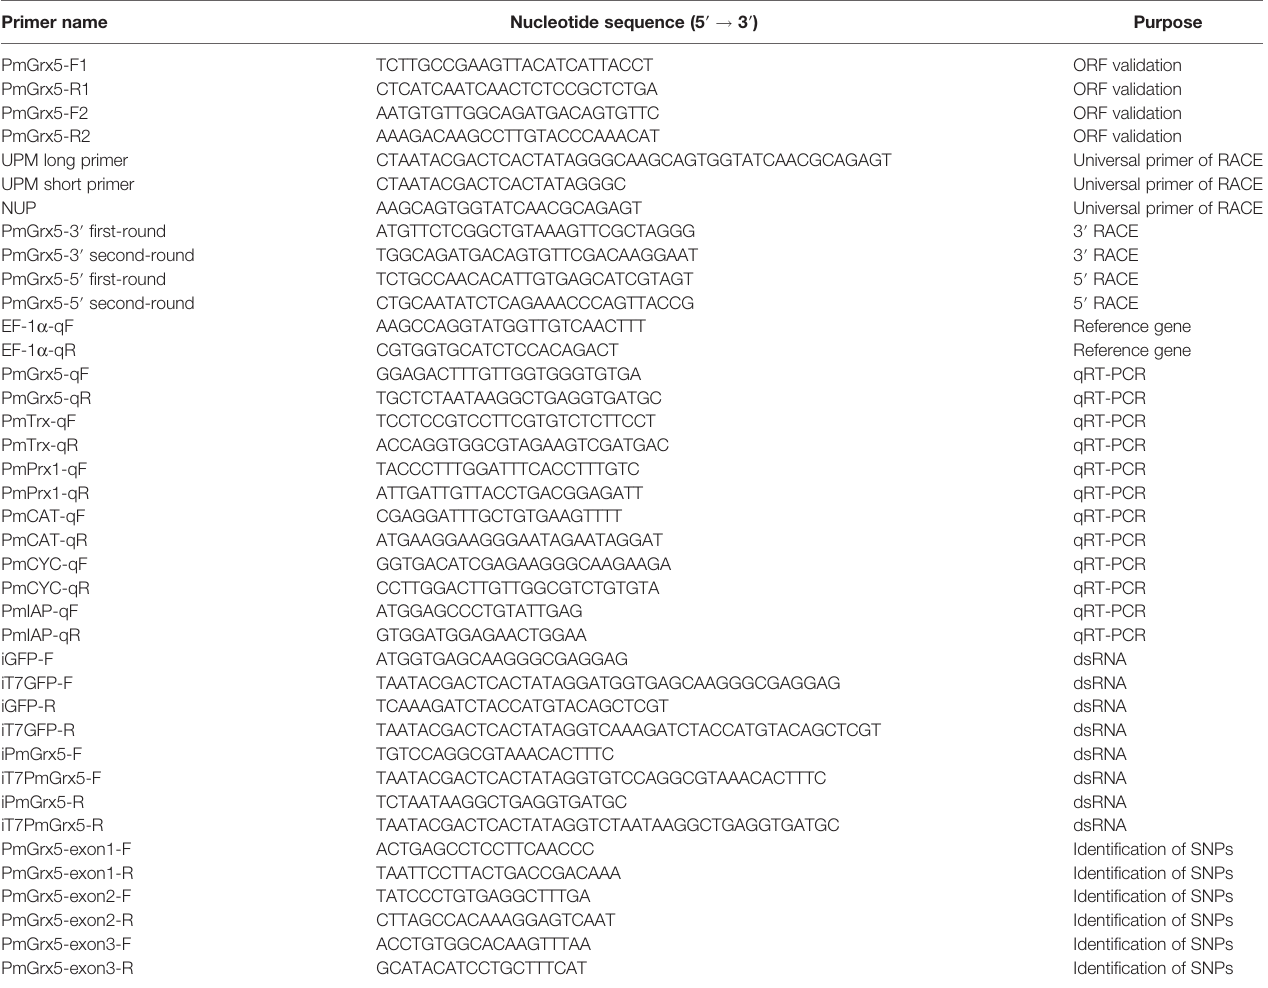
TABLE 1 | PCR primers used in this